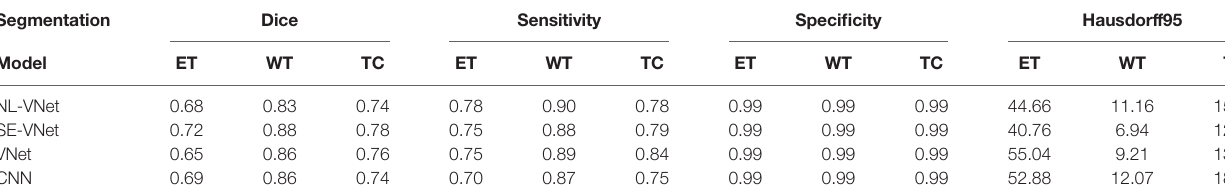
TABLE 3 | Segmentation results of ablation experiments on the BraTS 2020 dataset. Segmentation Dice Sensitivity